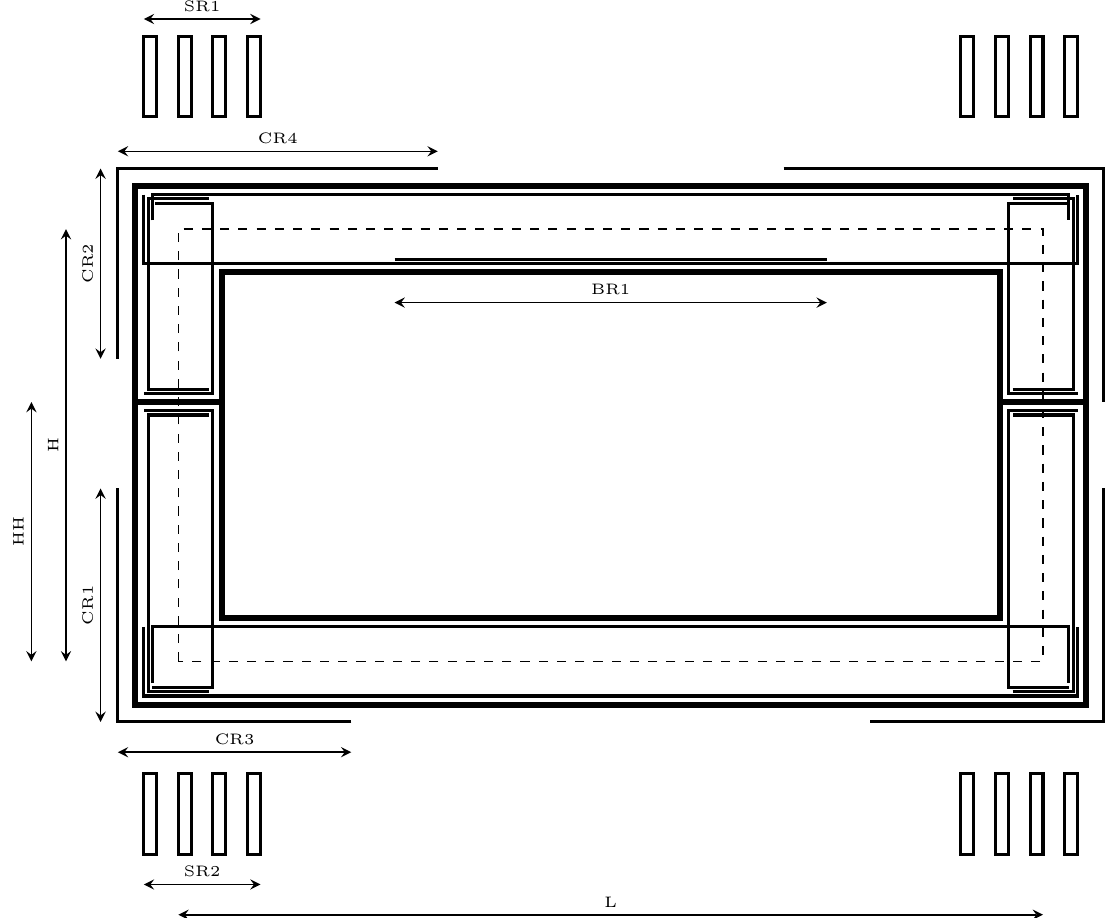
Figure 1. Parameters of the RCPHF considered in the optimization